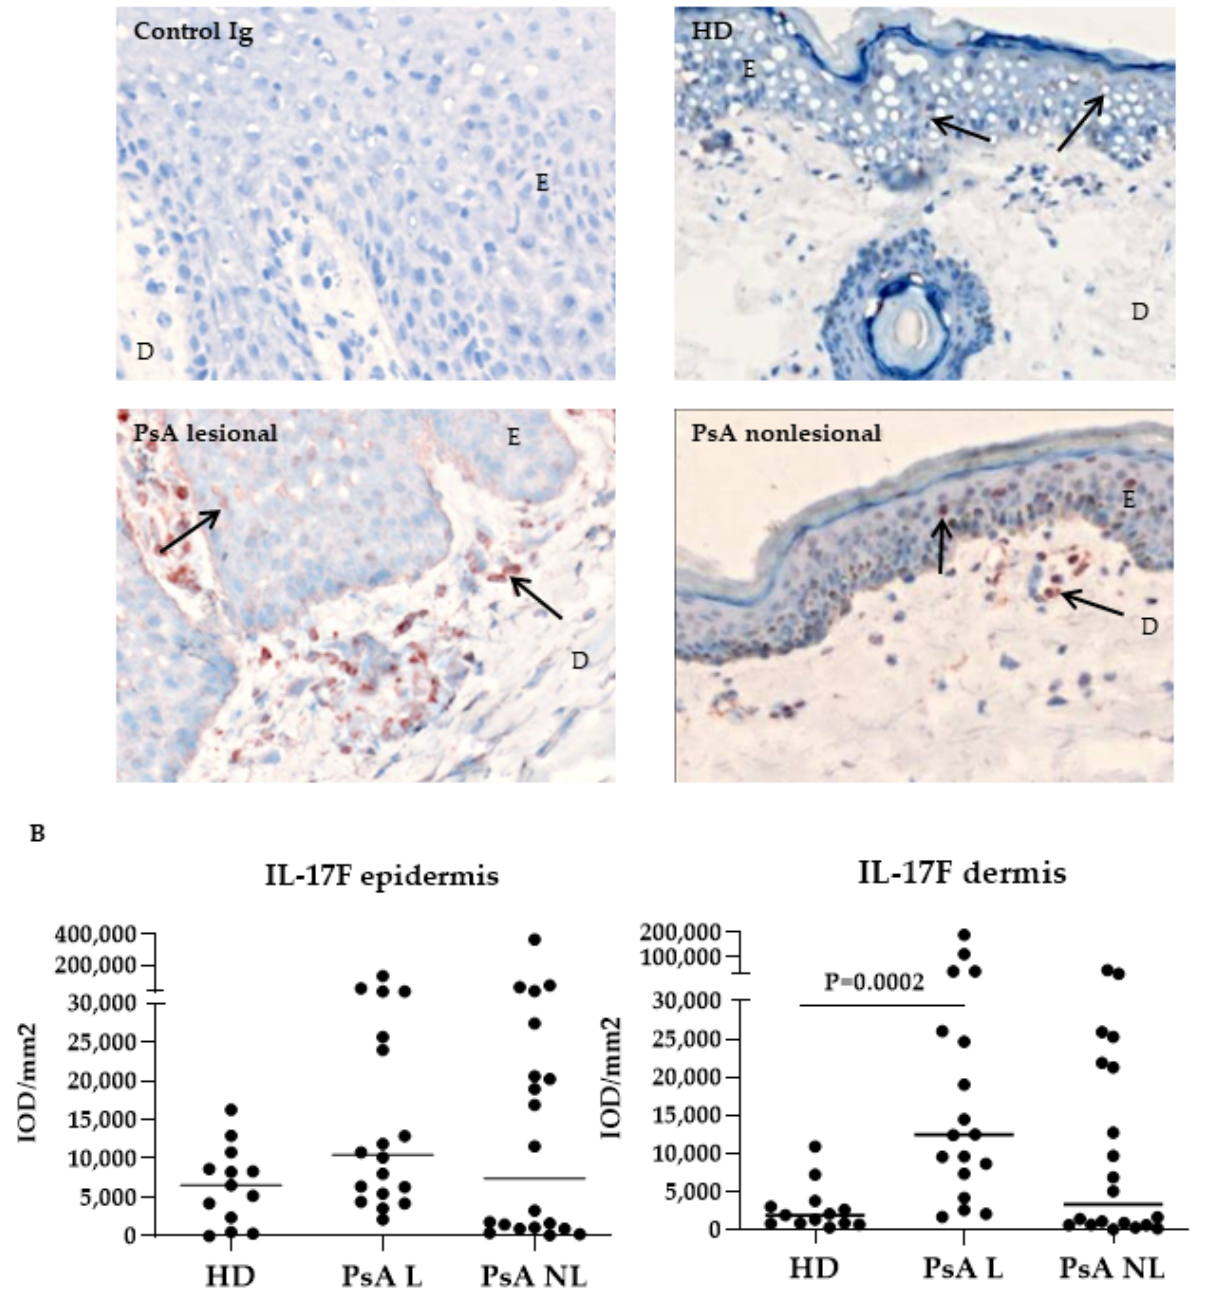
Figure 2. Expression of IL-17F was higher in the dermis of lesional psoriatic skin compared to healthy donor skin. ( A ) Representative immunohistochemical staining of baseline IL-17F expression (arrows) in skin from HD and PsA patients. Original magnification 200 × . ( B ) Quantification of IL-17F (Kruskal-Wallis test, epidermis p = 0.17, dermis p = 0.0002) expression in HD, PsA L skin and PsA NL skin. Results are shown as median IOD/mm 2 and IQR of epidermis and dermis of HD and PsA patients. Per subject the median expression level of 18 high-power fields is used for analysis. p values given in the graphs are cal-culated from a post Dunn’s test. E, epidermis; D, dermis; IL, interleukin; HD, healthy donor; PsA, psoriatic arthritis; L; lesional, NL; nonlesional, IOD; integrated optical density, IQR; interquartile range.